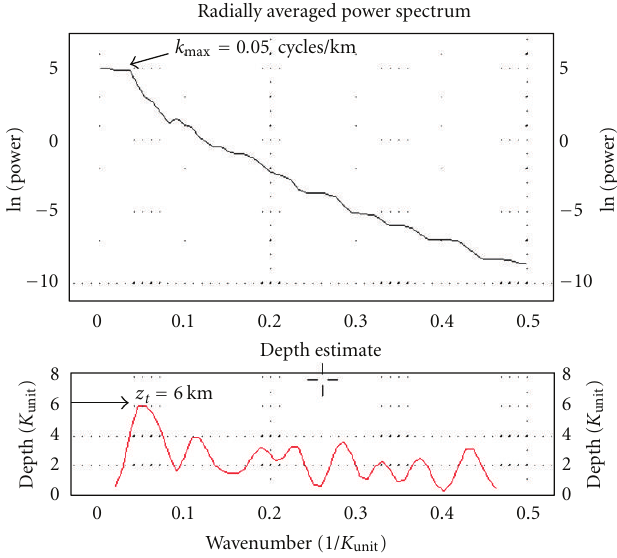
Figure 14: Log power spectrum analysis of Lake Magadi generated from aeromagnetic data.